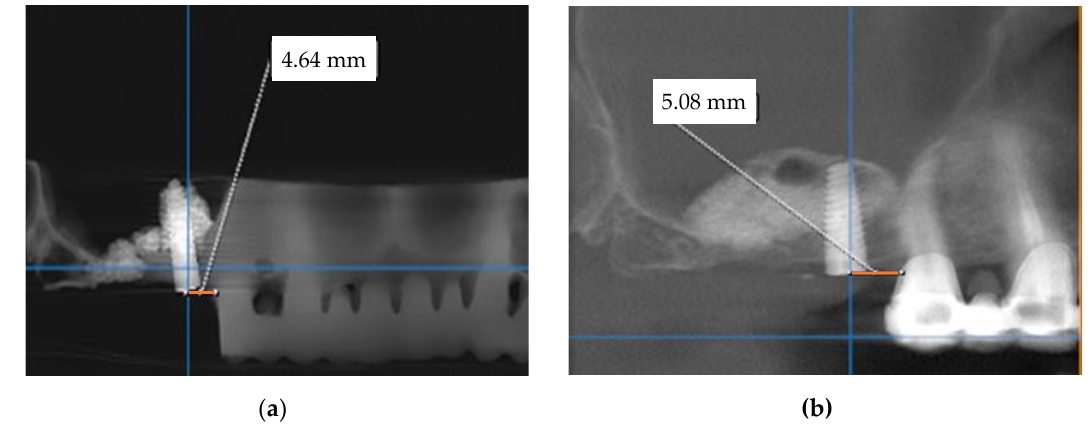
Figure 7. Measurement of the mezio-distal position of the implant (i.e., distance from the anterior tooth to the middle of the implant ( D1 )) on ( a ) the training CBCT model ( D1-3D ) and on ( b ) the postoperative CBCT ( D1-P ) - panoramic view.